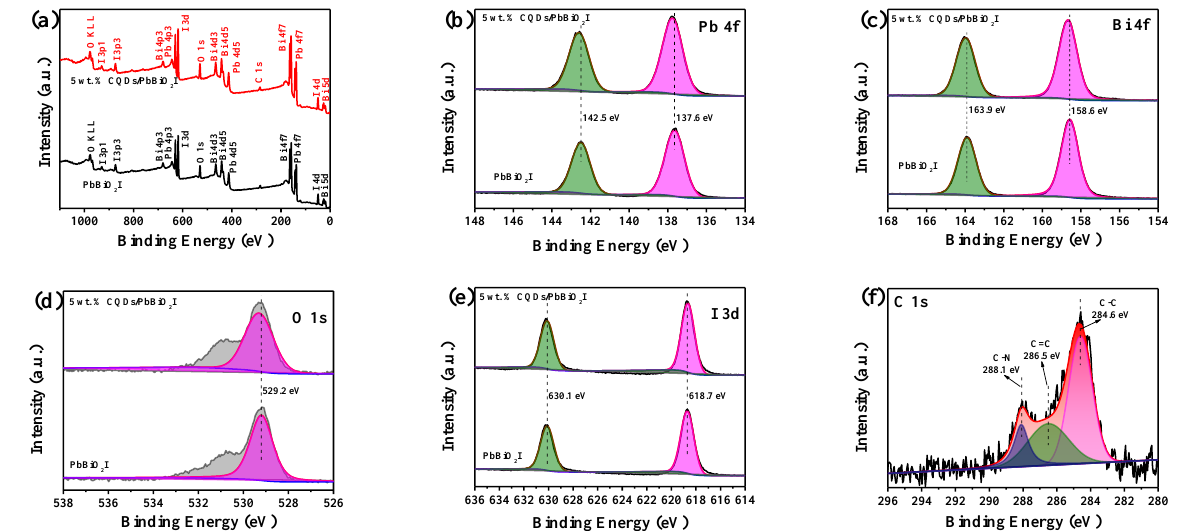
Figure 2. XPS spectra of PbBiO 2 I and 5 wt.% CQDs/PbBiO 2 I: ( a ) survey, ( b ) Pb 4f, ( c ) Bi 4f, ( d ) O 1s, ( e ) I 3d, ( f ) C 1s.